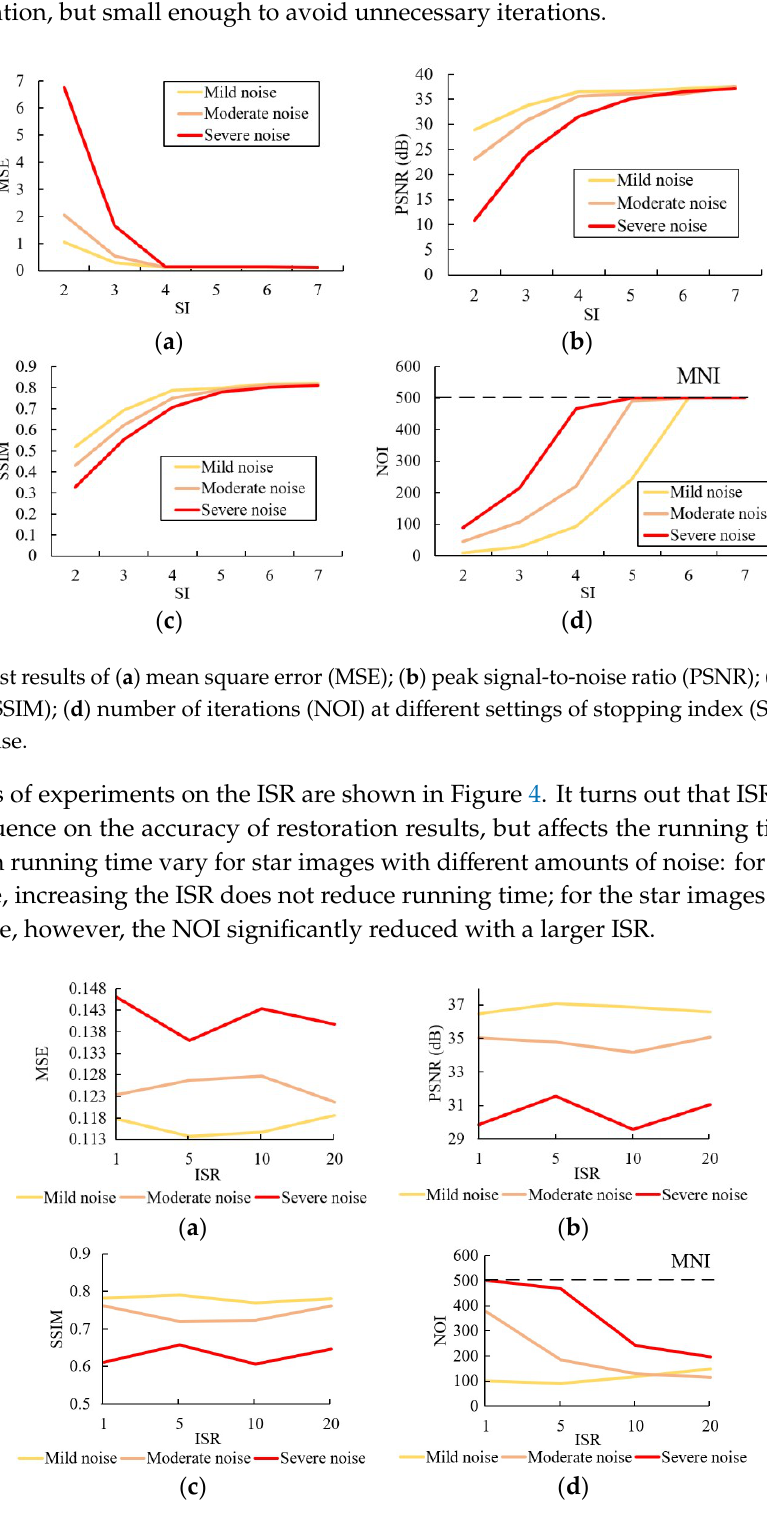
Figure 4. Test results of ( a ) MSE; ( b ) PSNR; ( c ) SSIM; ( d ) NOI at different settings of initial searching radius (ISR)) for three levels of noise.